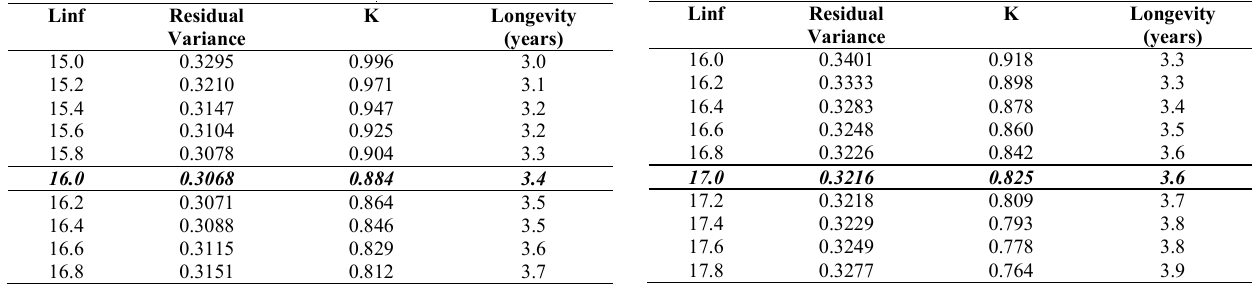
Table 5. Parameters of von Bertalanffy growth formulae for Atherinella brasiliensis males in southern Brazil and residual variance with different simulated asymptotic lengths. Longevity estimates defined as the time (years) to attain 95% of the asymptotic length. In italics are the data that result in the best fit.